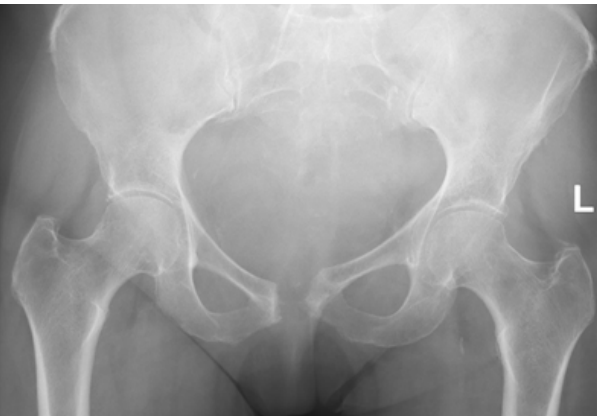
Figure 1. Patient with wide symphysis resection after SAS debride- ment. At the 6 weeks follow-up, the patient was able to stand on one leg and walk with two crutches. The examination was performed at the Department of Radiology, Aarhus University Hospital, Den-